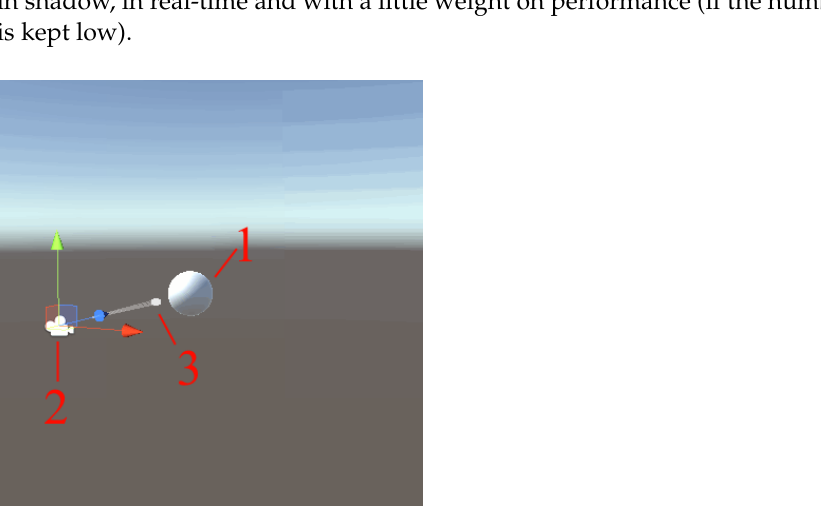
Figure 2. Light meter GameObject ( 1 —pictured as a sphere) with texture rendering camera in one position ( 2 ). The camera will change its position to calculate an array of RGB values from a very narrow texture ( 3 ), then converted to brightness. The light meter is placed at the end of each awake internode in the